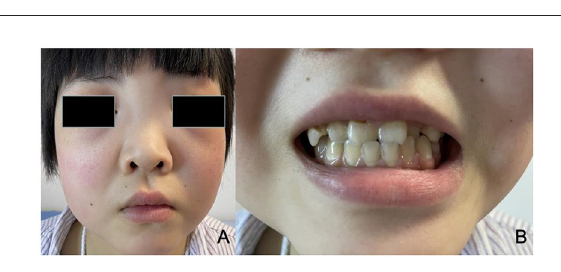
FIGURE3 (A) The patient has a wide flat nasal bridge, increased distance between the medial canthi, and flat cheeks. (B) The patient has fairly normal dentition with a sharp crown and poorly developed permanent